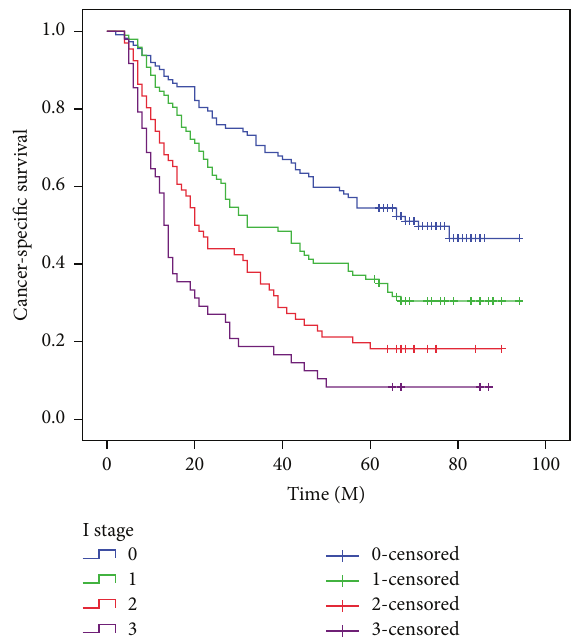
3-censored2-censored1-censored0-censored Figure5:The5-yearCSSinpatientswithI0,I1,I2,andI3was50.0%, 30.9%, 18.2%, and 8.3%, respectively ( 𝑃 < 0.001 ) (I0 versus I1, 𝑃 = 0.002 ; I1 versus I2, 𝑃 = 0.012 ; I2 versus I3, 𝑃 = 0.020 ).